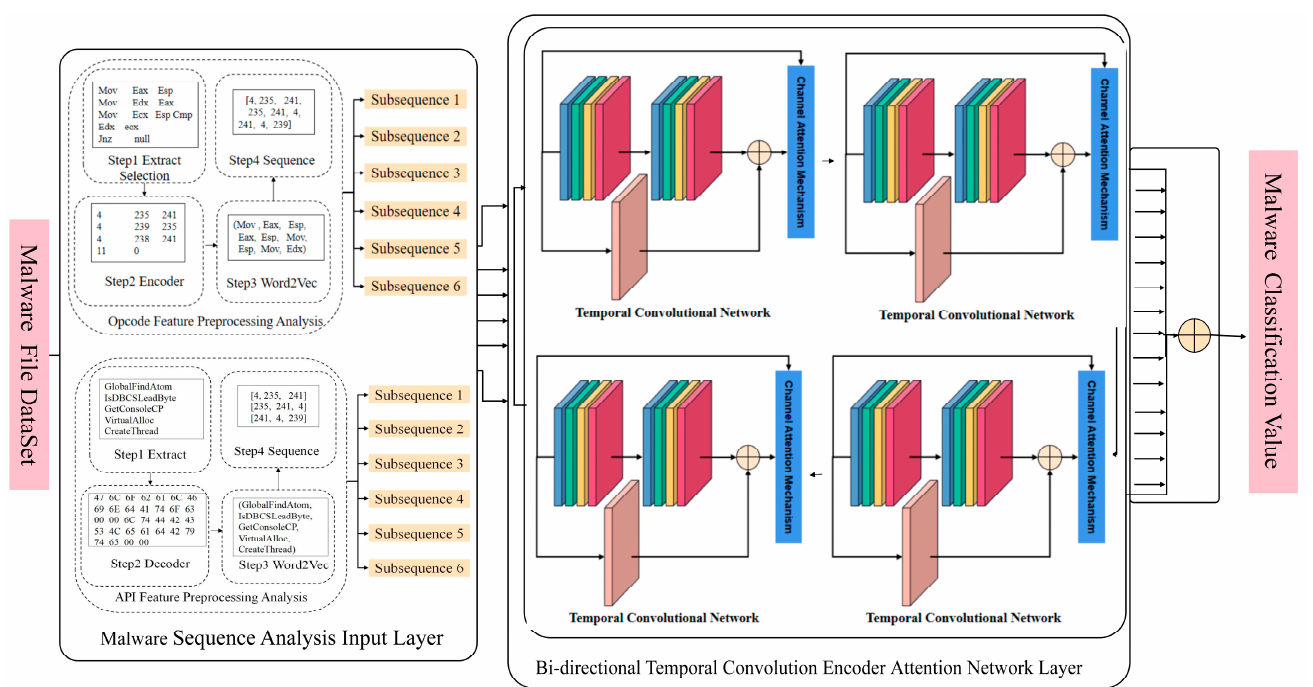
Figure 1. SFCWGAN-BiTCN-based malware detection framework.